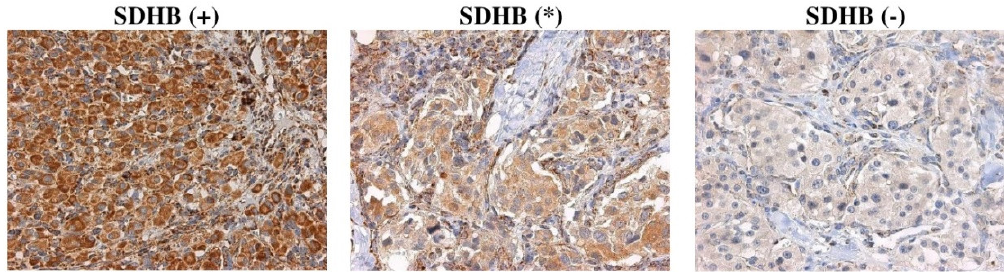
Figure 2. Representative images of SDHB immunostaining in CPGLs. (+) positive, (*) weak diffuse, (- ) negative. Magnification x400.